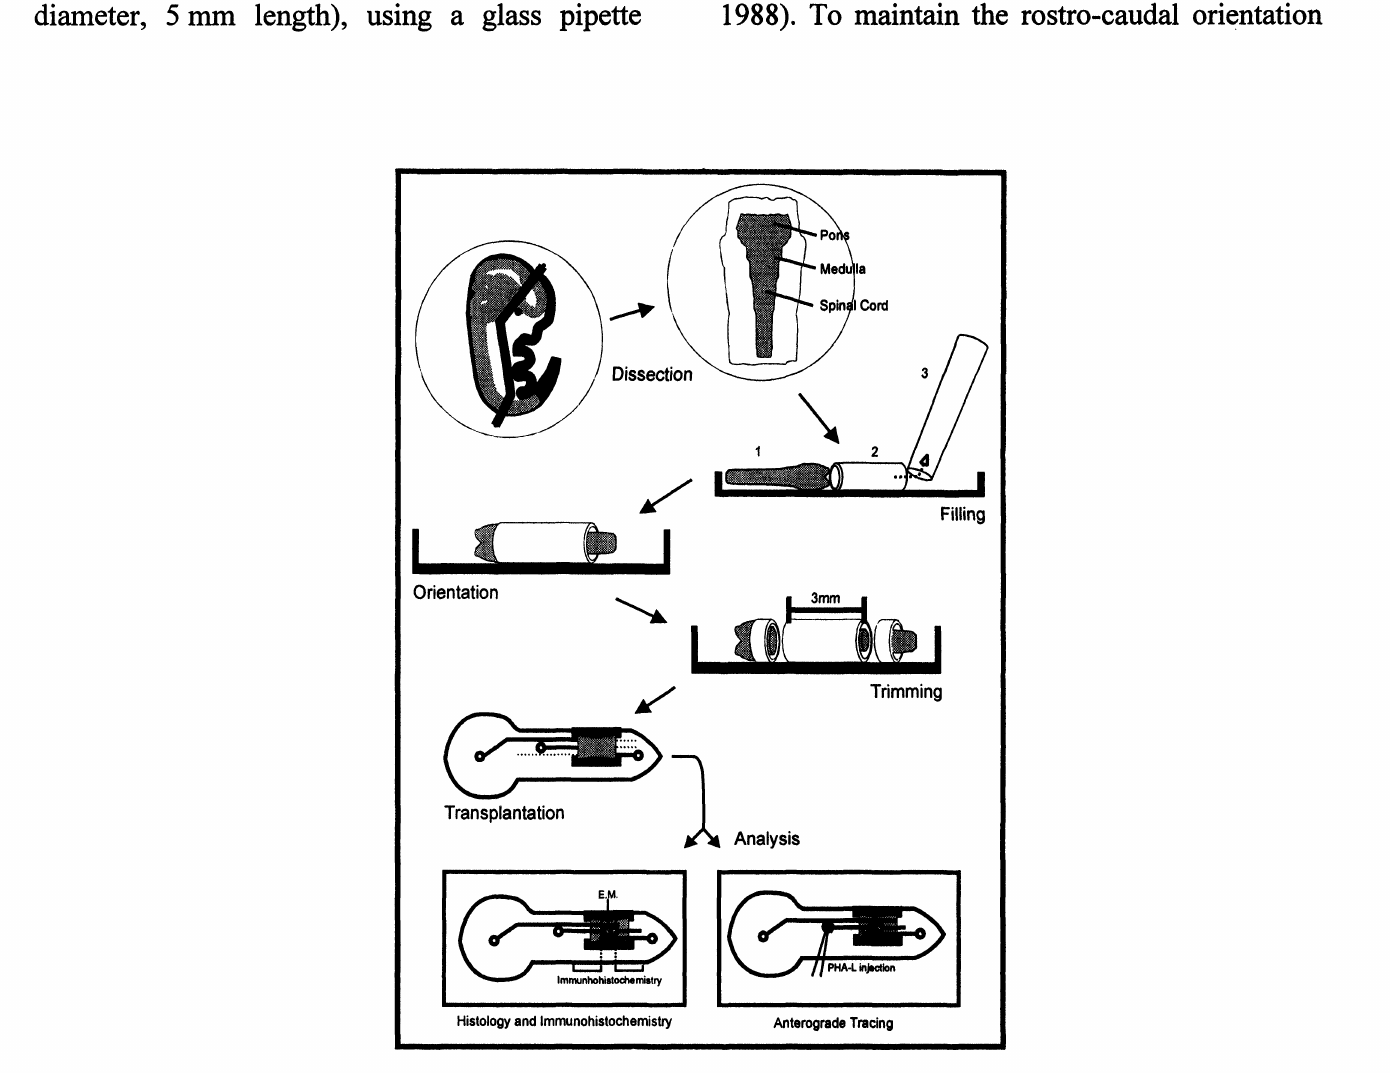
Fig. 1" Schematic drawing showing the procedures for filling the FSC tissue (1) into a mini-guidance channel (2) by gentle suction (3). The orientation, trimming, and transplantation of the FSC-containing mini-channels, as well as analysis of the histology, immunohistochemistry, and anterograde tracing of axons that entered the FSC graft are also